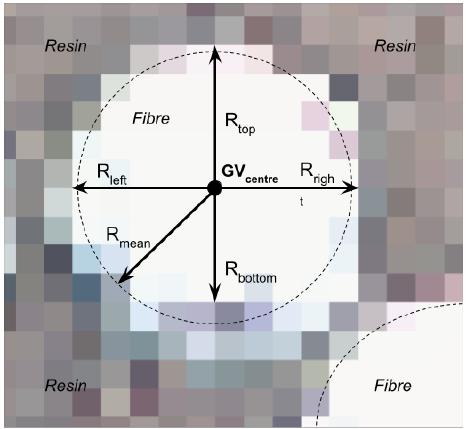
Figure 6. Mean fibre radius definition based on greyscale intensity visualised on magnified